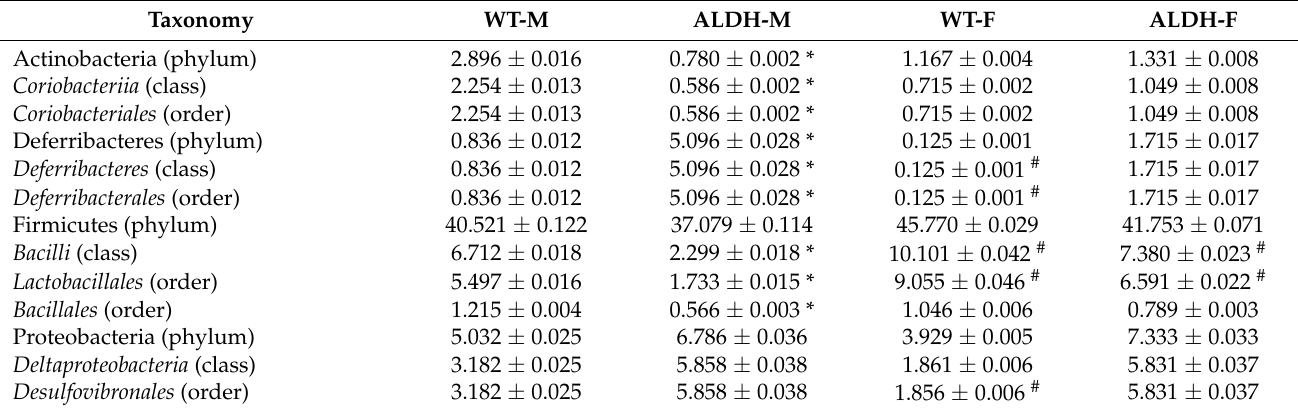
Table 3. Relative abundance of gut microbiota by